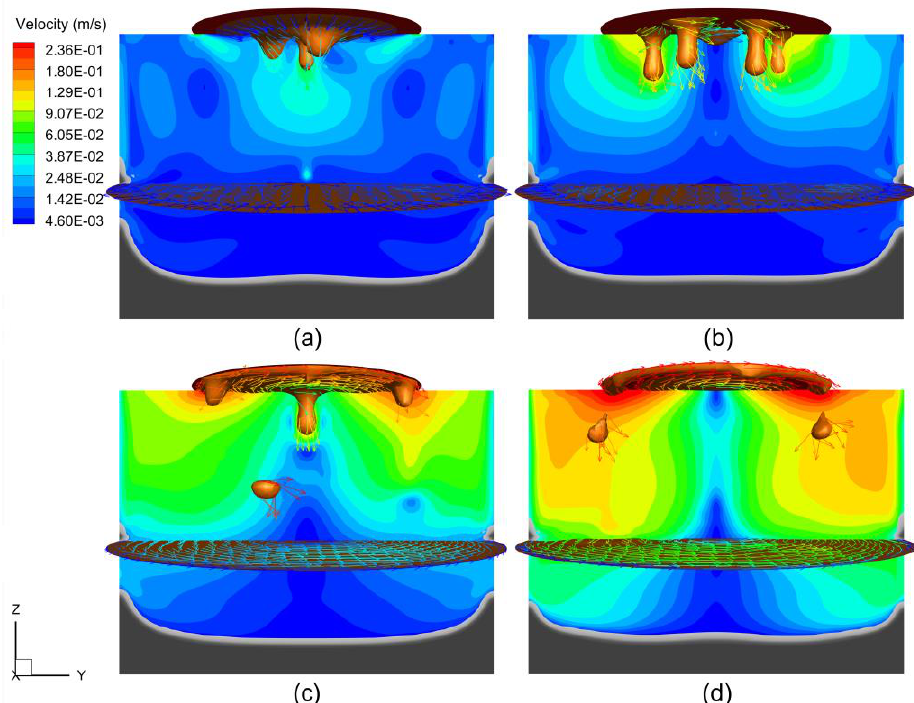
Figure 5. Predicted flow fields in the mold with the electrode rotating at different speeds: ( a ) 0; ( b ) 20 rpm; ( c ) 40 rpm; ( d ) 60 rpm. The current mesh height is 150 mm.